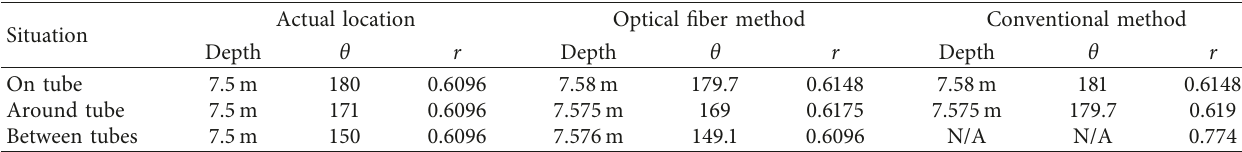
Figure 5: Result of simulation with different locations. (a, d, g) Actual location of defect, (b, e, h) location determination by the optical fiber method, and (c, f, i) location determination by the conventional method. Table 2: Location determination by different